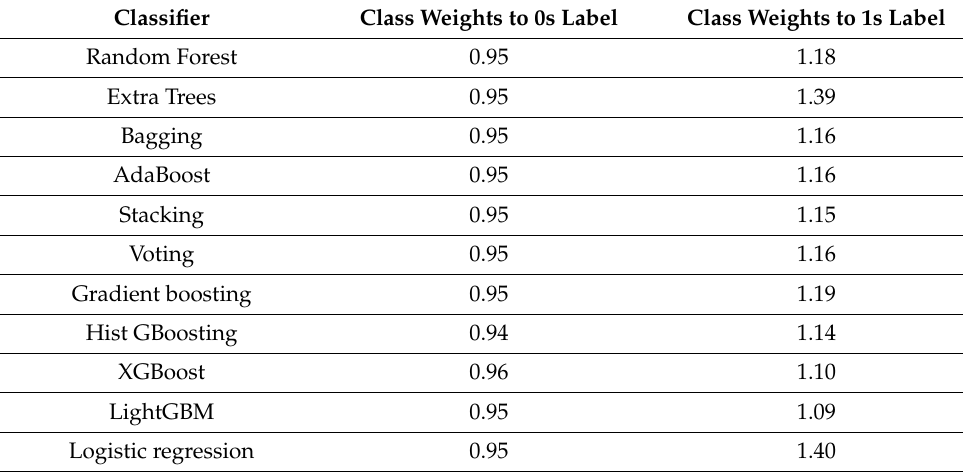
Table 5. Class weights.